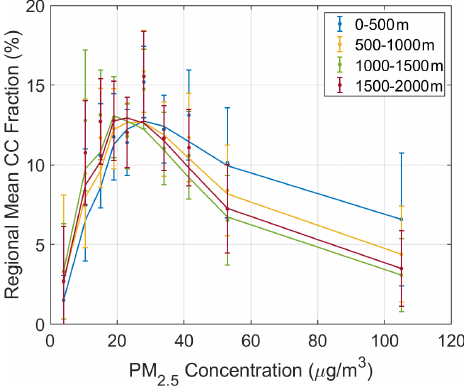
Figure 11. Convective cloud fraction (CCF) over regions with ter- rain heights in the ranges 0–500 (blue), 500–1000 (yellow), 1000– 1500 (green), and 1500–2000m (red) with respect to PM 2 . 5 con- centration during May–September 2016/17. Ten equally sampled PM 2 . 5 bins are defined for each terrain height range. The SDs are shown as error bars. Each solid line represents the three-point mov- ing average for dots in the corresponding color.